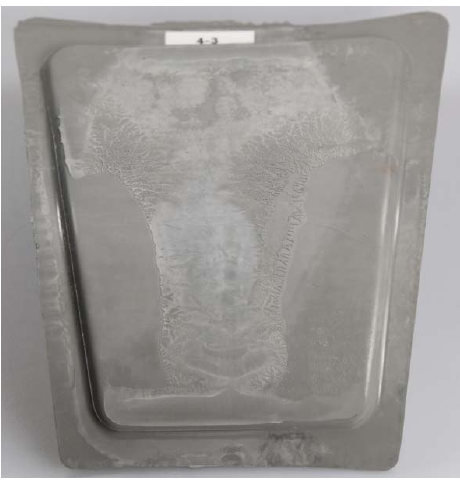
Figure 5. Formed hybrid laminates with sensor functionality at preheating temperature 200 °C and tool temperature 170 °C.